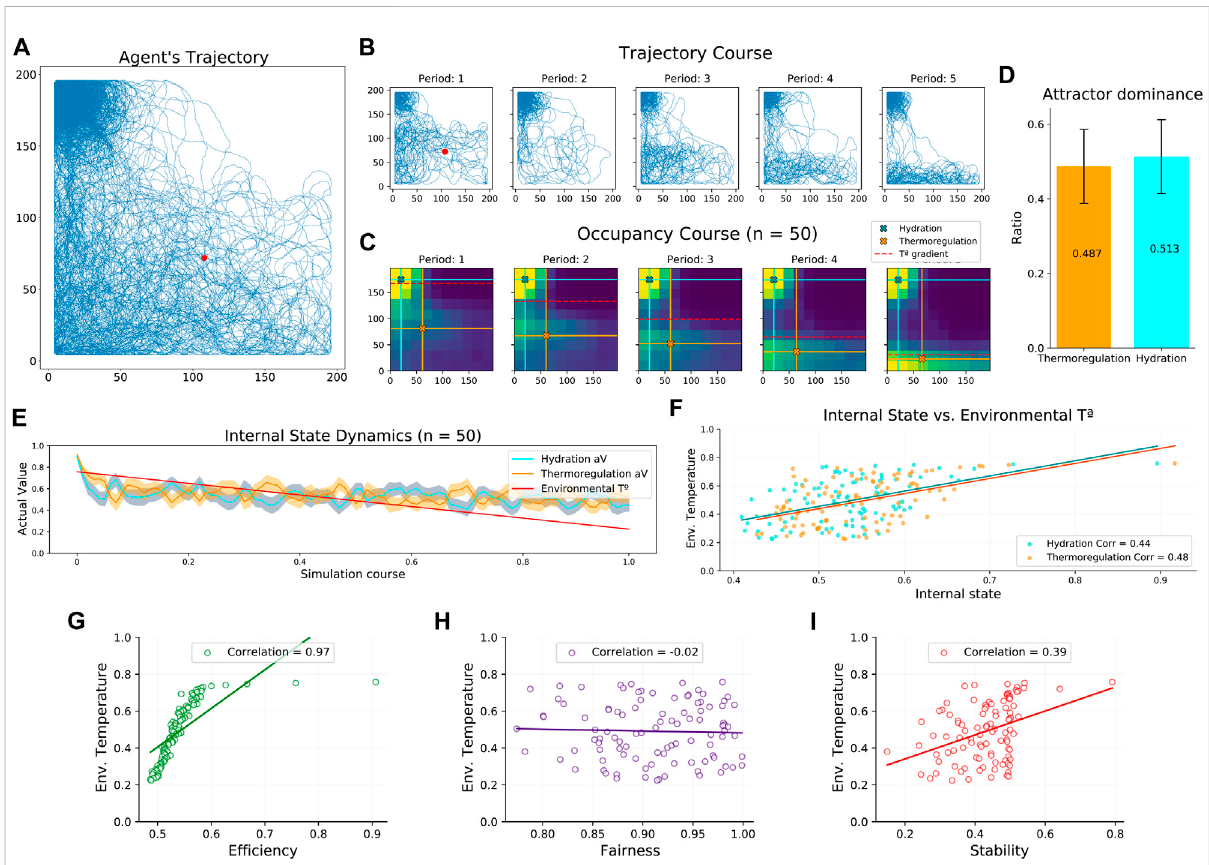
FIGURE 4 Agent ’ s performance in a dynamic environment. (A) Agent ’ s trajectory tracked along a complete experiment. The red dot represents starting location,randomizedacrossexperiments. (B) Agent ’ strajectorytrackedalongacompleteexperiment(sameasa)dividedinto fi veperiods. (C) Mapof occupancy divided into fi ve periods. Color crosses illustrate the mean position during hydration (blue) and thermoregulation (orange) attractor dominance. The red dashed line illustrates the variable slope location of the dynamic temperature gradient. (D) Mean attractor dominance (E) Mean agent internal state dynamics and environmental temperature. The shaded area indicates the internal state variance. (F) Mean internal state dynamics correlated with the environmental temperature. (G) Ef fi ciency dynamics correlated with the environmental temperature. (H) Fairness dynamics correlated with the environmental temperature. (I) Stability dynamics correlated with the environmental temperature. Aggregated results from 50